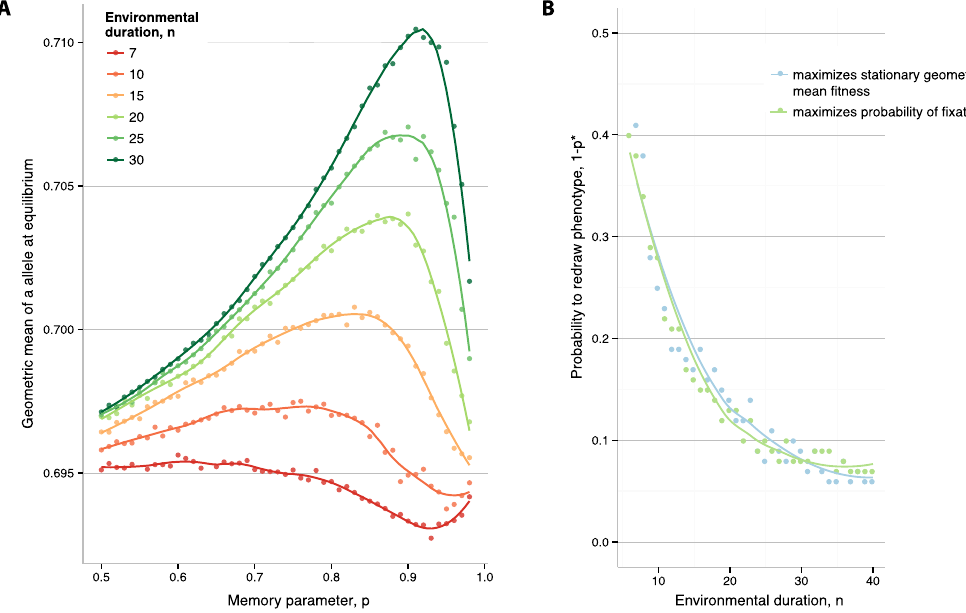
Figure 5. Fixation probabilty and geometric mean fitness. ( A ) Geometric mean fitness in stationary state, as a function of phenotypic memory p . The colors represent different environmental durations n , as indicated. Population size N = 1000. Variance of the a phenotype, Var ( Φ a ) = 0.0033. ( B ) Comparison of the phenotypic memory that maximizes the fixation probability and the memory that maximizes stationary geometric mean fitness. Population size N = 1000. Variance of the a phenotype, Var ( Φ a ) = 0.0033. The curves show cubic spline fits to the simulated